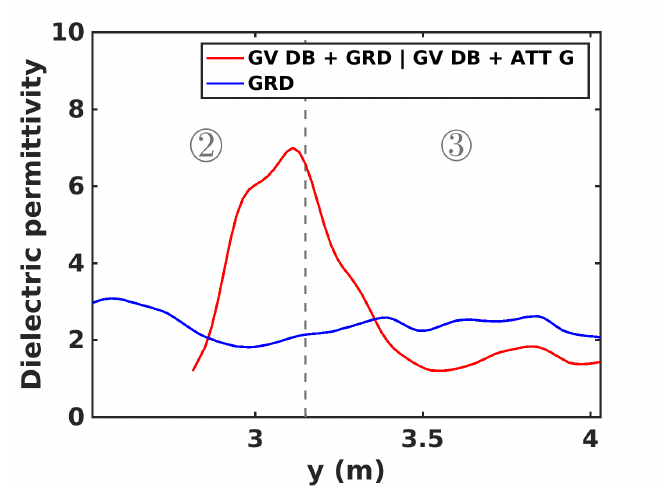
Figure 17. Dielectric constant